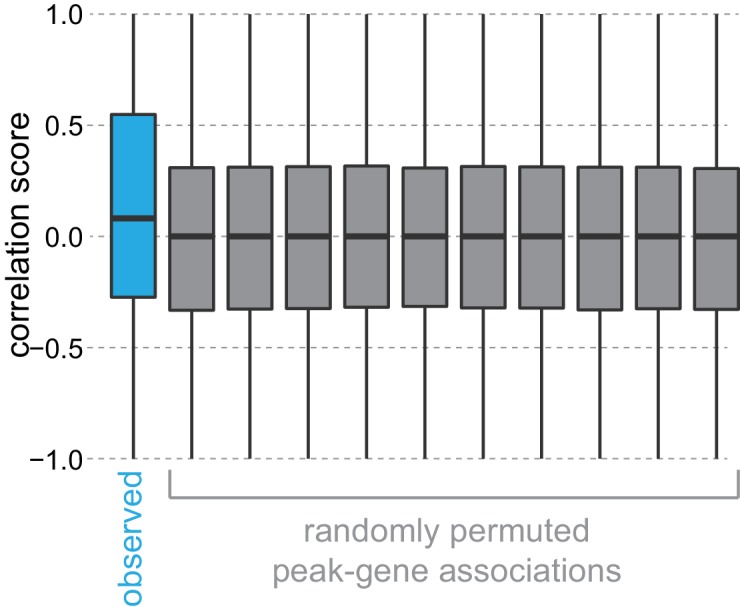
Permutation of peak-gene associations.To test the correlation between gene expression and nearby peak accessibility, we calculated mean peak accessibility scores for each peak and mean gene expression scores for each gene across neuronal cell classes, then scaled these scores per peak and per gene between 0 and 1. These scaled values were used to compute Pearson correlation scores between each peak and the nearest (positionally associated) gene. The distribution of observed correlations between peak accessibility and gene expression of positionally associated genes are shown in blue, compared to randomly permuted associations between peaks and genes, shown in gray. Boxplots show medians (middle bar), quartiles (boxes), and 1.5 × interquartile ranges (whiskers). A Kolmogorov–Smirnov test between observed correlations and a randomly-permuted correlation set had a p-value of 0, while a comparison between two randomly-permuted correlation sets had a p-value of 0.334.